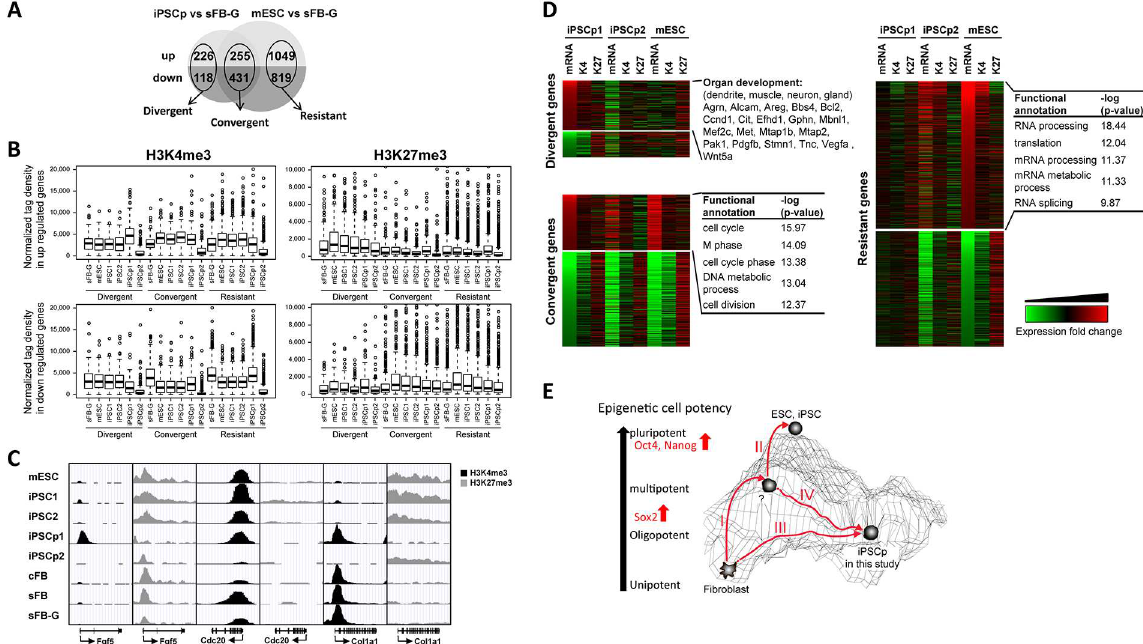
Fig 4. Identification of early and late responder genes from the partial iPSC analysis. (A) Categorization of the differentially expressedgenesamongiPSCps, mESCs, and sFB-G into three groups: the divergent,the convergent, and the resistant genes. (B) The H3K4me3and H3K27me3levels were plotted, dependingon the responsiveness of the genesto the inductionof pluripotency(C) The UCSC genomebrowsershows the chromatinstates of the divergent(Fgf5), convergent (Cdc20), and resistant (Col1a1) genesin all cell types. The positionsand directionsof transcriptionof the genes are indicatedbelow the panel. (D) The three groupsare listed accordingto their expressionand histonemodificationfold changevalues. The gene ontologyanalysisshows highly significant biological functions associatedwith the differentiallyexpressedgenes. (E) A model for the step-wise acquisitionof pluripotency. Sox2 was identified as an early responder gene.